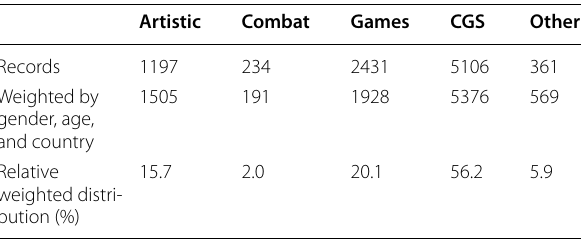
Table 4 Raw, weighted, and relative distribution of responses by sports category